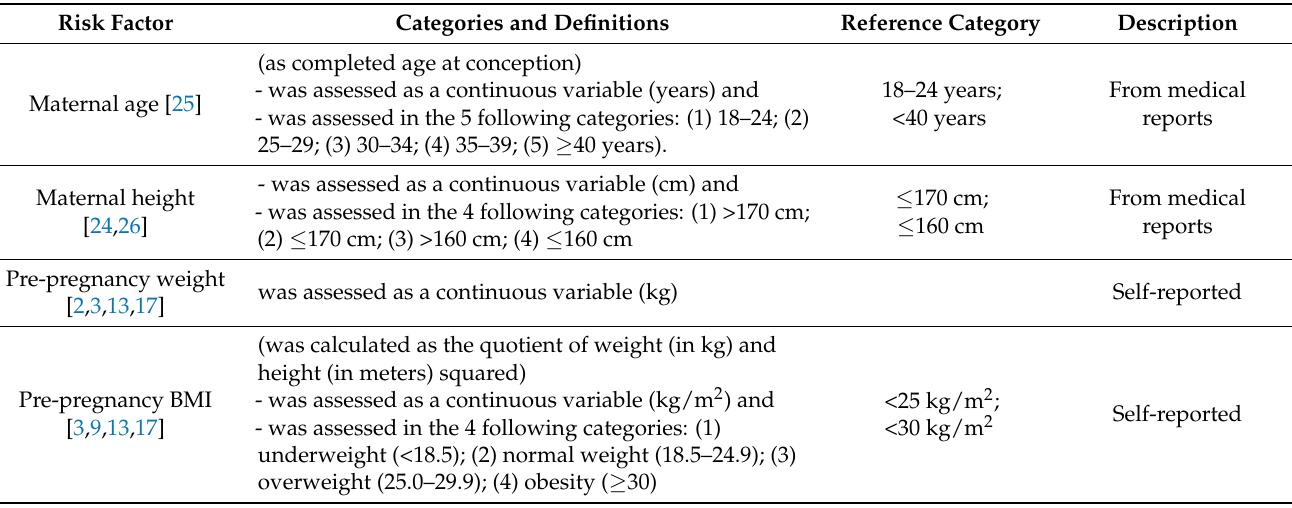
Table 1. Definitions of macrosomia risk factors identified from prior